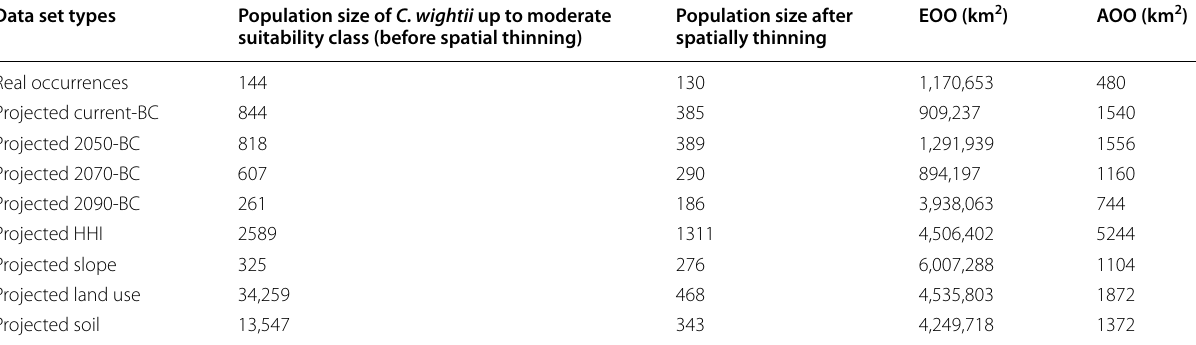
Table 12 Population dynamics of C. wightii and IUCN evaluation of extent of occurrence and area of occupancy calculated for both real data set and projected data set with BC and NBC variables Data set